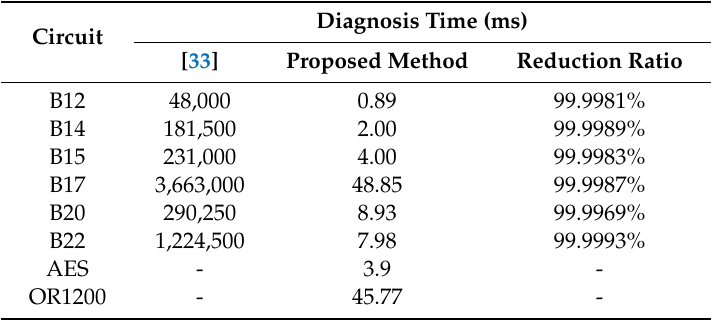
Table 7. Diagnosis